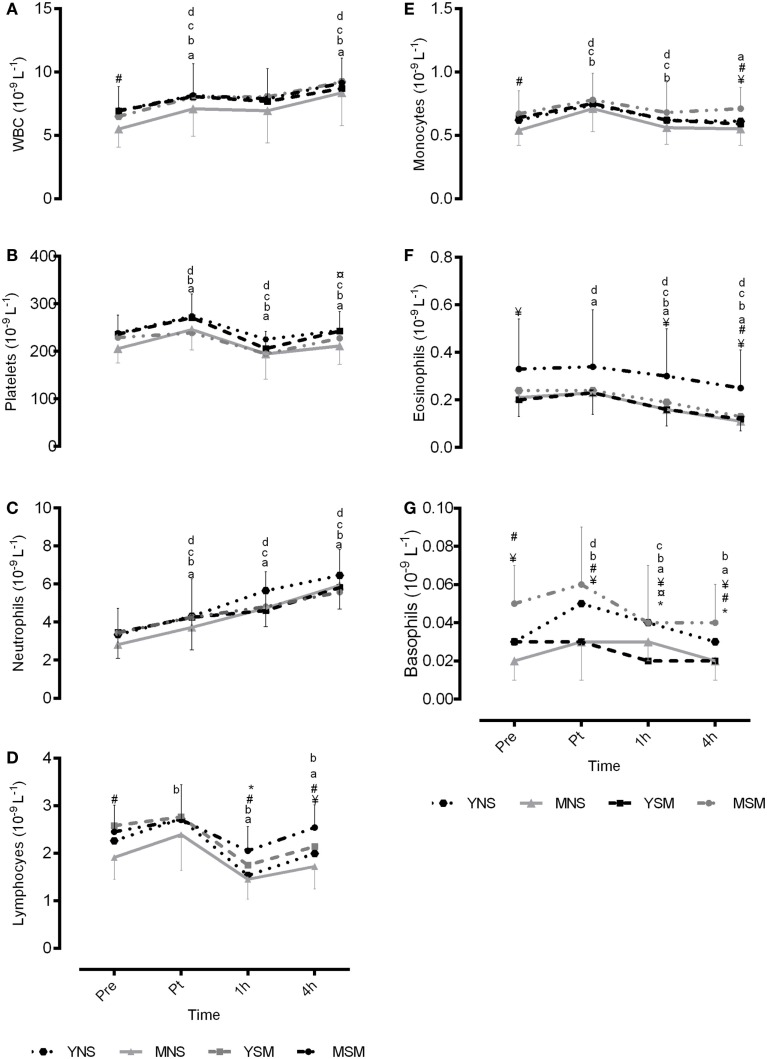
Mean ± SD total and sub-population leukocyte count pre, post, 1- and 4-h post exercise for younger and middle-aged smokers and non-smokers. *represents significantly different between YSM and YNS (P < 0.05), # represents significantly between MSM and MNS (P < 0.05), and ¥ represents significantly different between YSM and MSM (P < 0.05). ¤ represents significantly different between YNS and MNS (P < 0.05). Within changes for YSM, YNS, MSM, and MNS are represented by (A–G), respectively (P < 0.05).